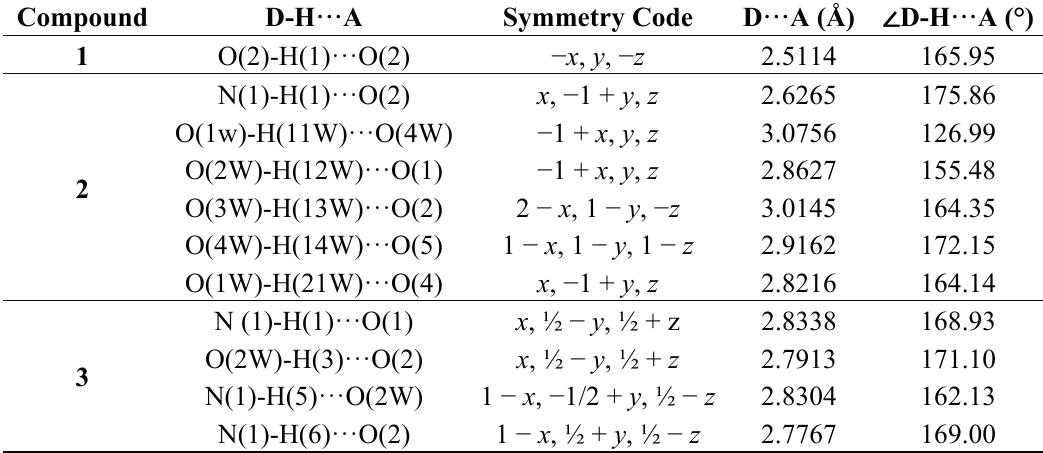
Table 3. Selected Hydrogen Bond Lengths (Å) and Angles (°) for Compounds 1 – 3